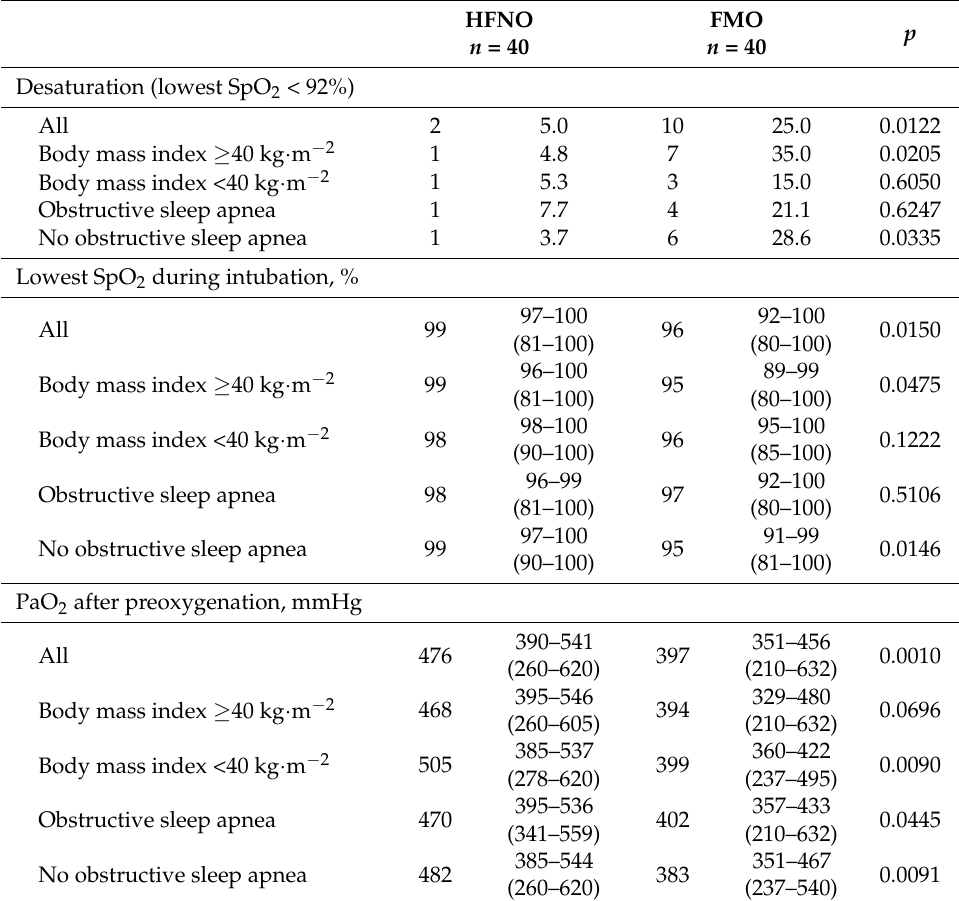
Table 5. Subgroup analyses by body mass index and obstructive sleep